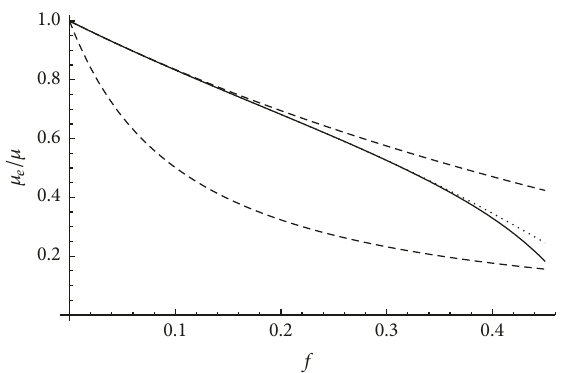
Figure 2: The same dependencies as in Figure 1 but for 𝜌 = −0.9 .